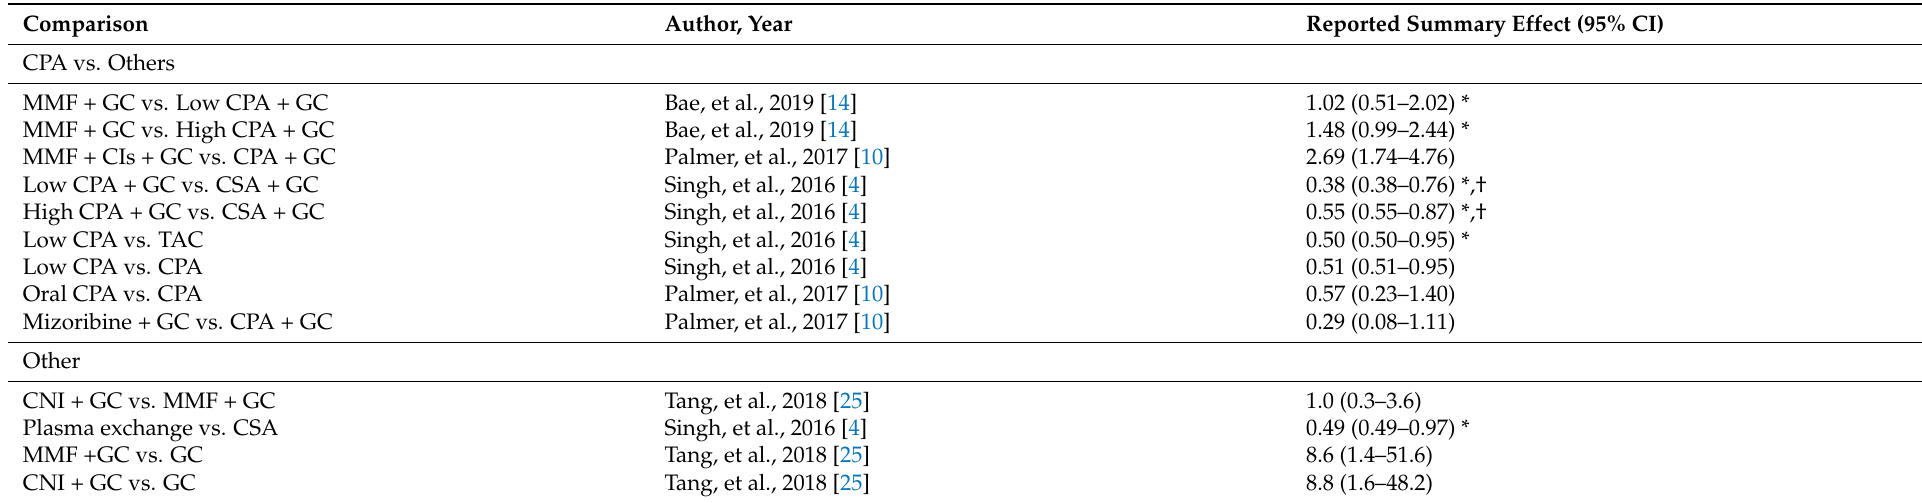
Table 3. Complete and partial remission rates of induction therapy in lupus nephritis (Network meta-analysis).